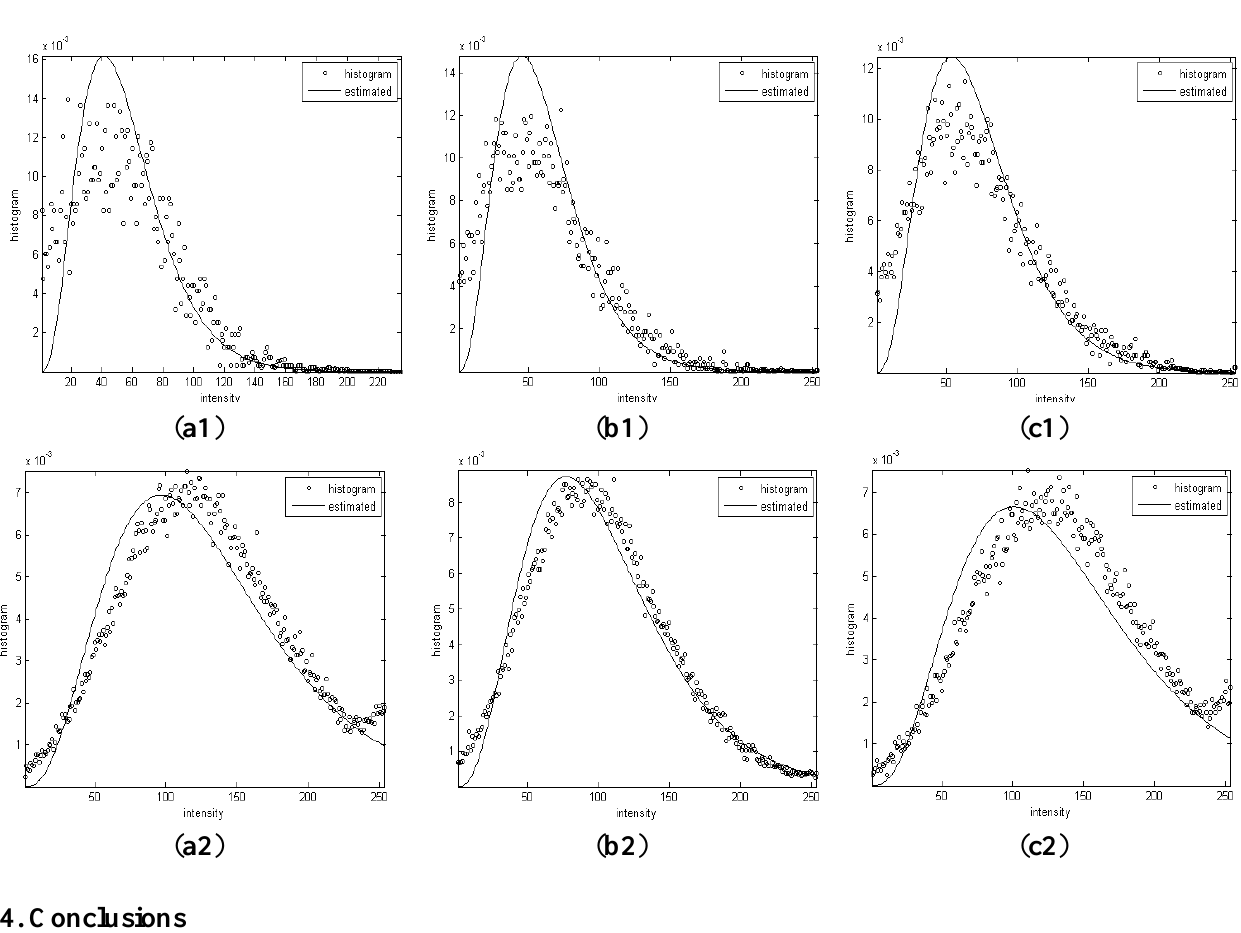
Figure 9. The histogram for two segmented homogeneous regions and gamma distribution curves with estimated